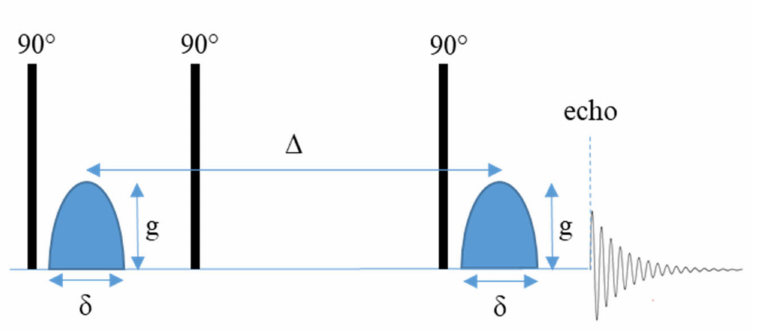
Figure 1. Stimulated echo pulse field gradient (PFG) pulse